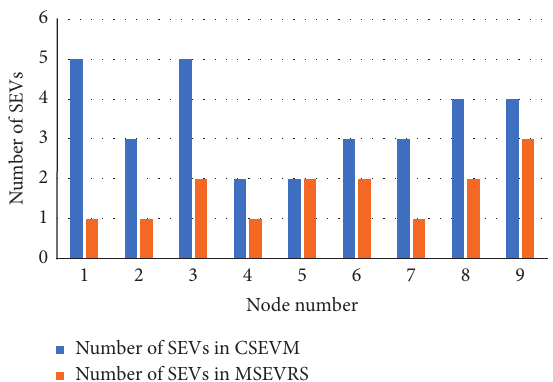
Figure 4: Number of SEVs at every node in MSEVRS and CSEVM.